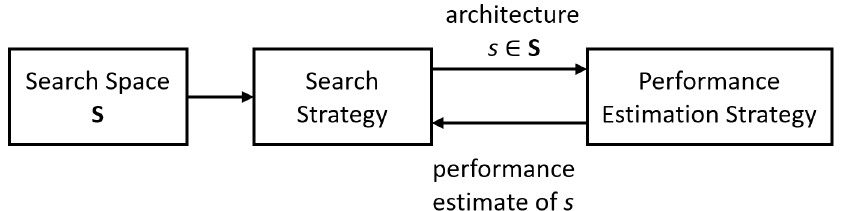
Figure 1. Diagram showing neural architecture search methods. An architecture s from a predefined search space S is selected using a search strategy. The architecture is evaluated using a performance estimation strategy, which returns the estimated performance of s to the search strategy. Source: adapted from [20] .